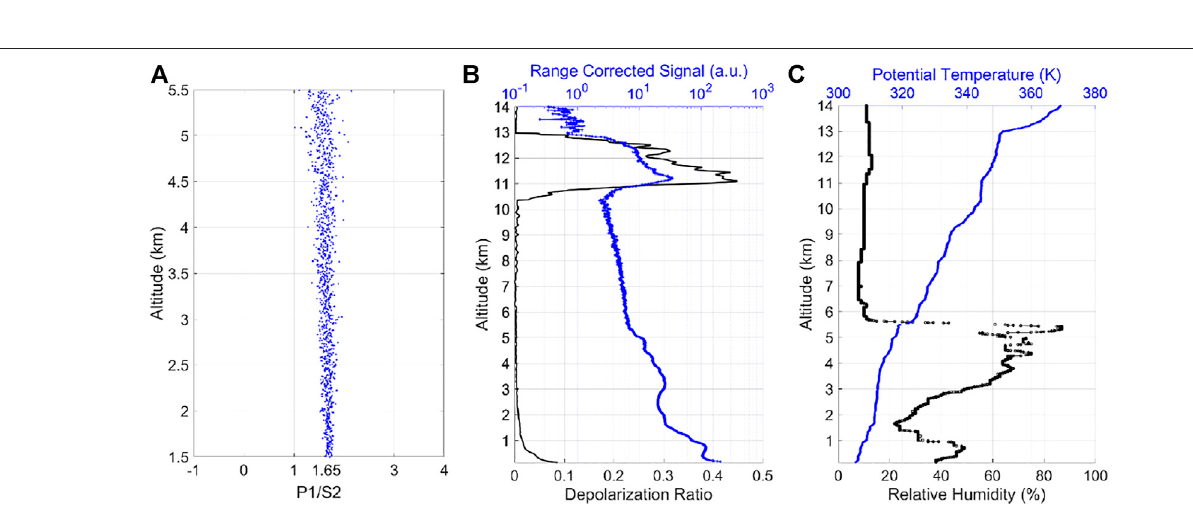
Frontiers in Physics |